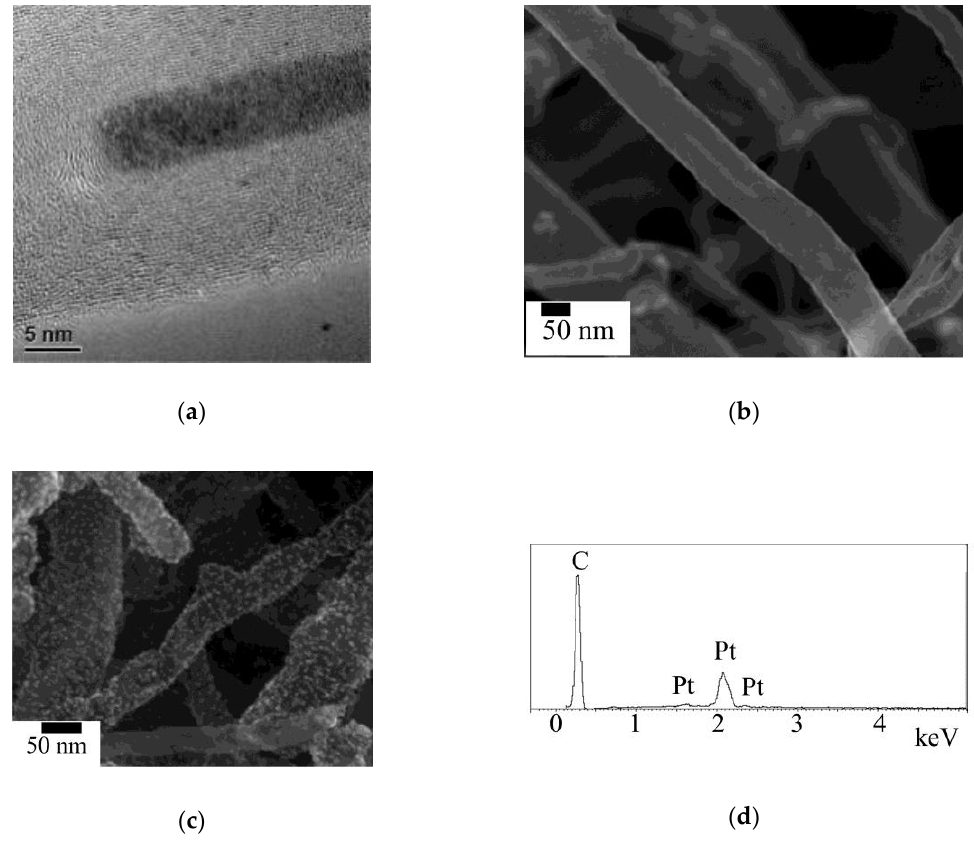
Figure 2. ( a ) TEM image of a typical carbon nanotubes (CNT) concerning the studied sample; ( b ) SEM image of an isolated pristine CNT; ( c ) SEM image of platinum-decorated multiwall CNT (Pt-MWCNT); ( d )Energy-DispersiveX-raySpectroscopy(EDS)inarepresentativesectionofPtnanoparticlessupported on a CNT